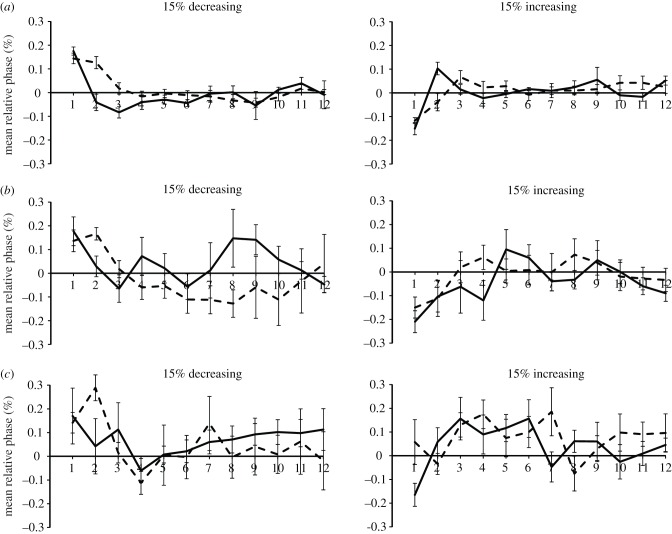
Mean relative phase values for 15% stimulus change (decreasing and increasing IOIs) for control participant (a), Mathieu (b) and Marjorie (c). Solid lines represent phase perturbation and dashed lines, period perturbation.